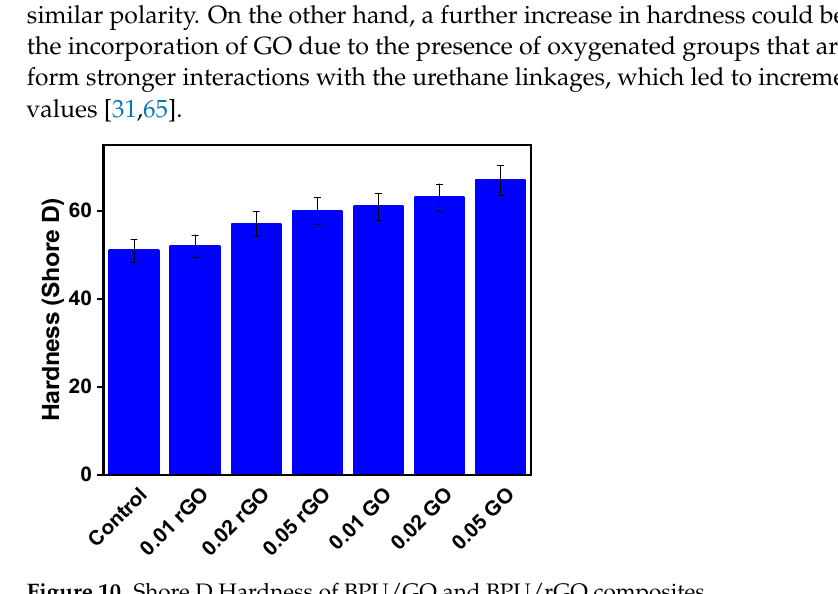
Figure 10. Shore D Hardness of BPU/GO and BPU/rGO composites.